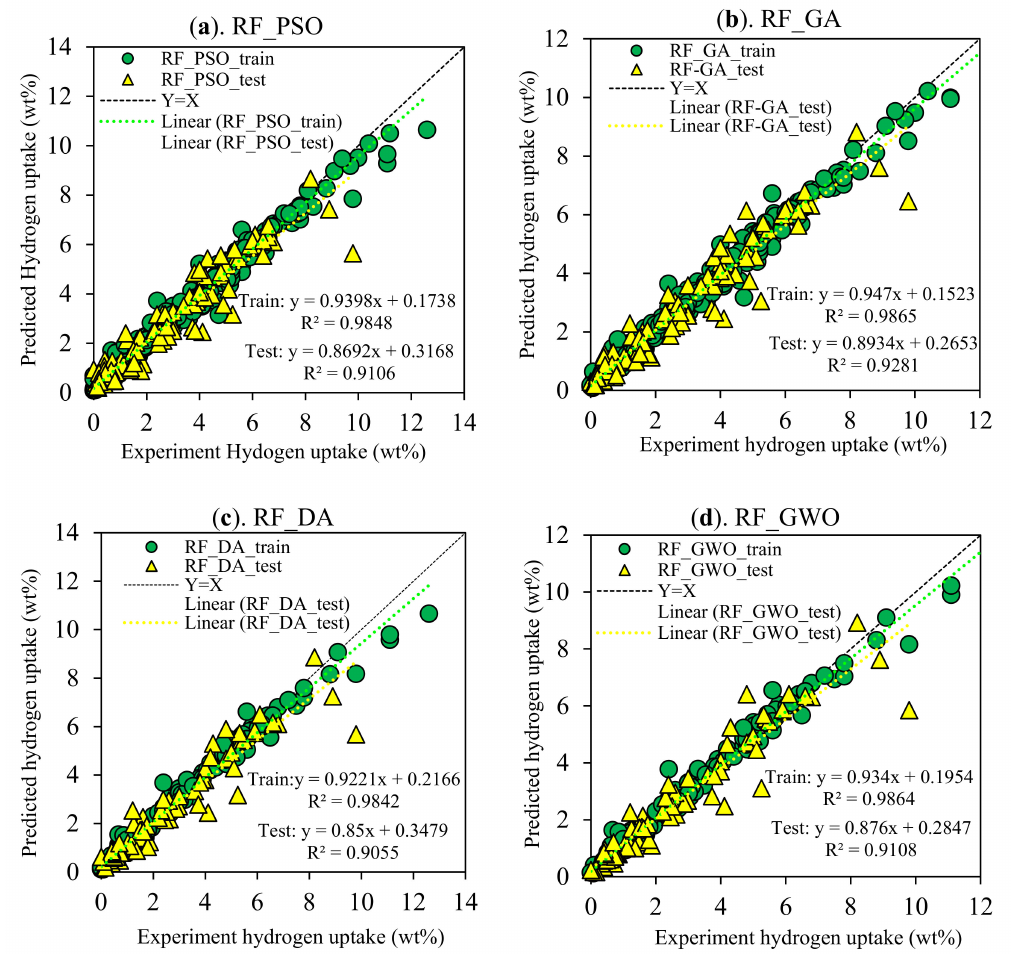
Figure 5. Observing the real and predicted values of hydrogen uptake on porous carbon in the train and test phases (circles and triangles represent the real and predicted values, respectively).